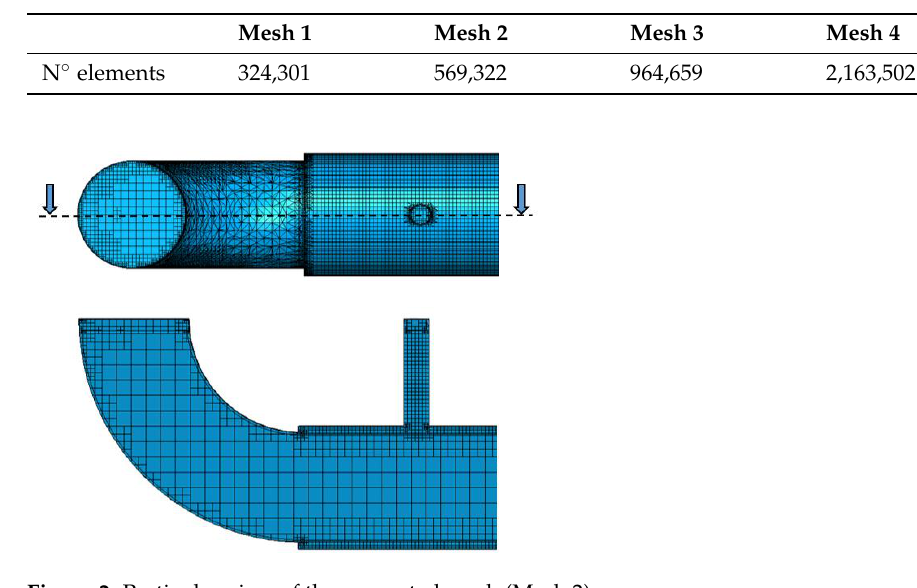
Table 3. Number of elements of each mesh.